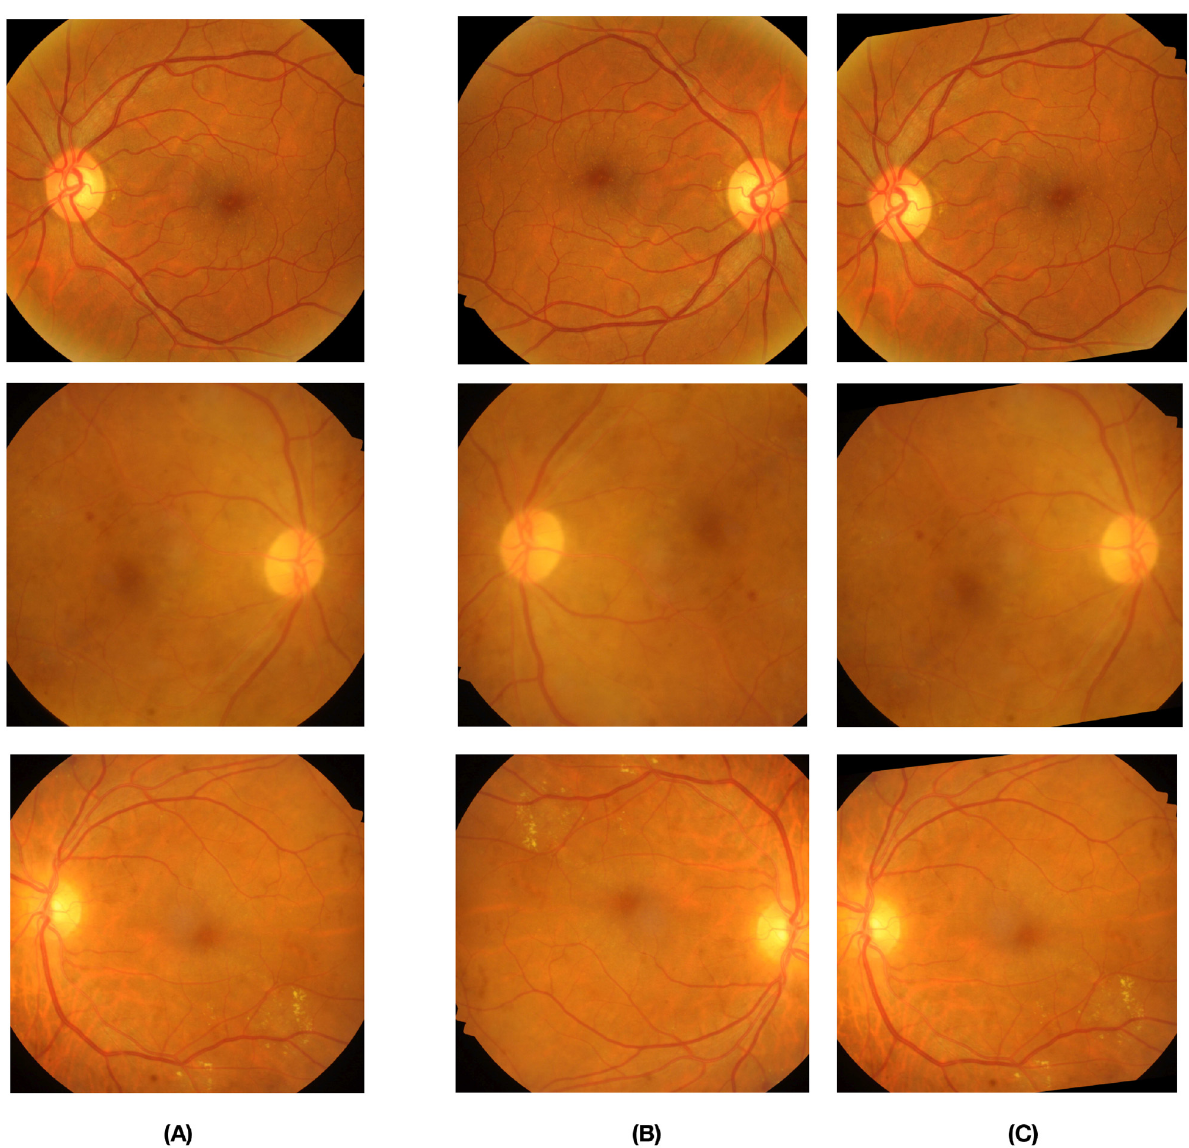
Fig 2. Reprenstative fundus images depicting our augmentation techniques. The images marked under column (A) are the original fundus images that are to be augmented. The fundus images under columns (B), (C) are the images generated owing to flipping and random rotations ranging from 10˚ to 40˚